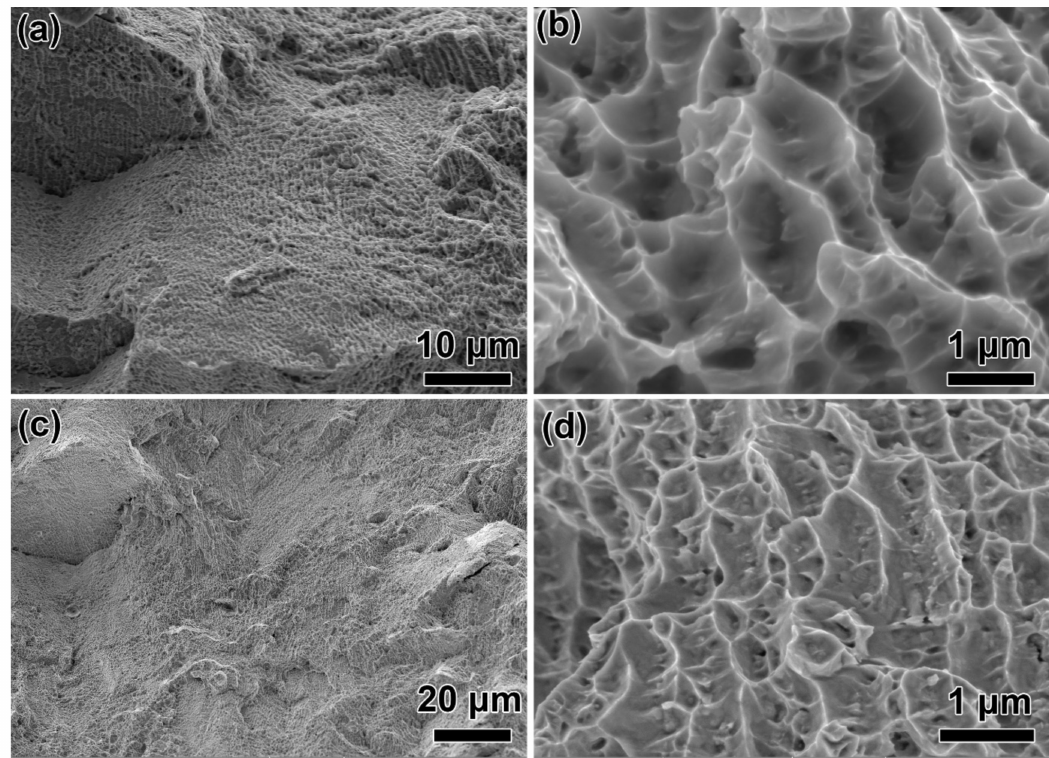
Figure 8. Fracture of the as-built and HTed GTD222. ( a , b ) as-built, ( c , d ) HTed